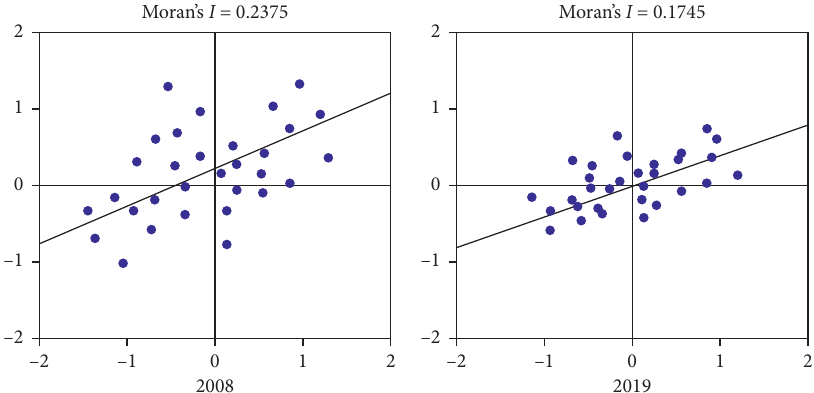
Figure 3: Moran index scatterplot of energy consumption of 31 provinces in China in 2008 and 2019.